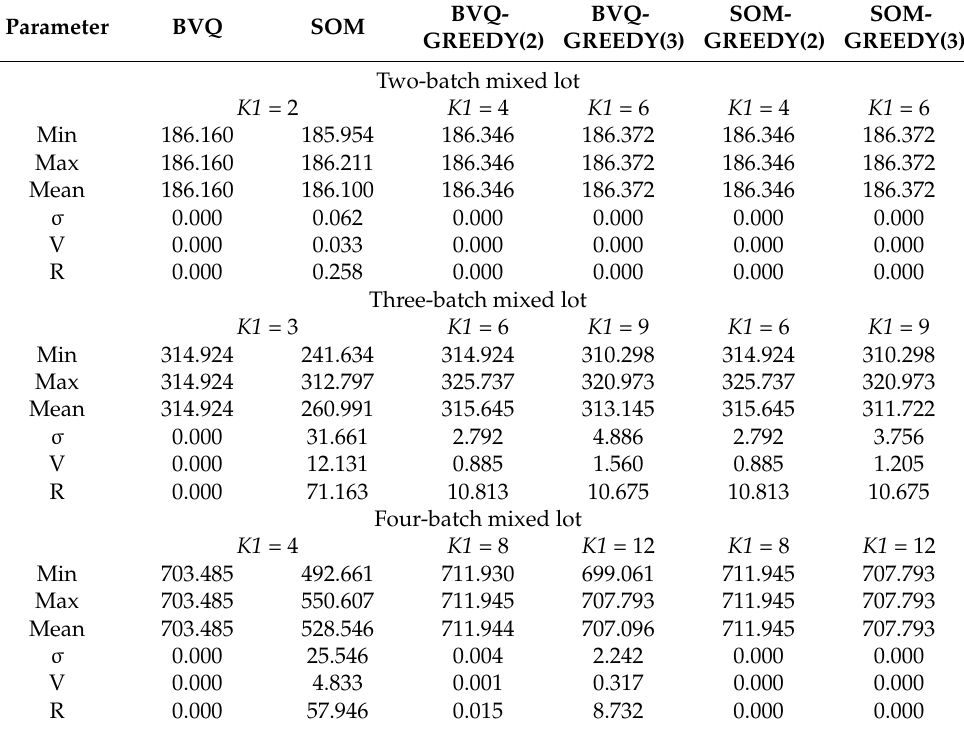
Table A6. Objective function value summarized after 30 attempts (Euclidean distance, initialization by